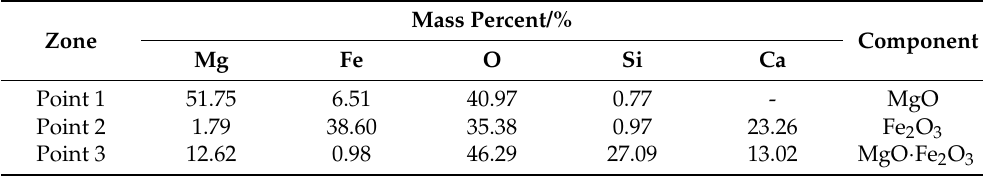
Table 7. EDS analysis of Fe 2 O 3 -MgO-CaO sample before